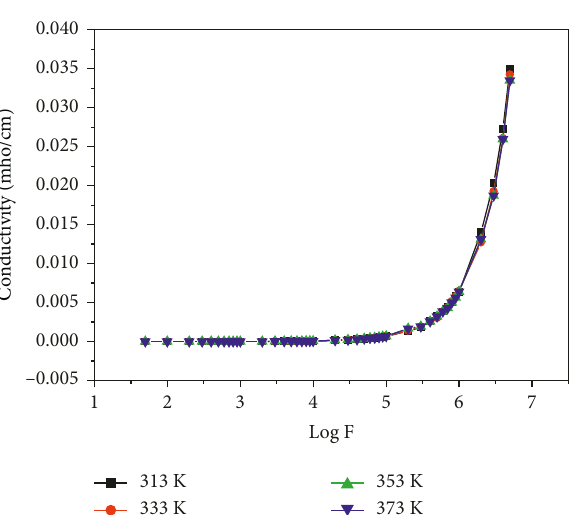
Figure 13: Real modulus vs imaginary